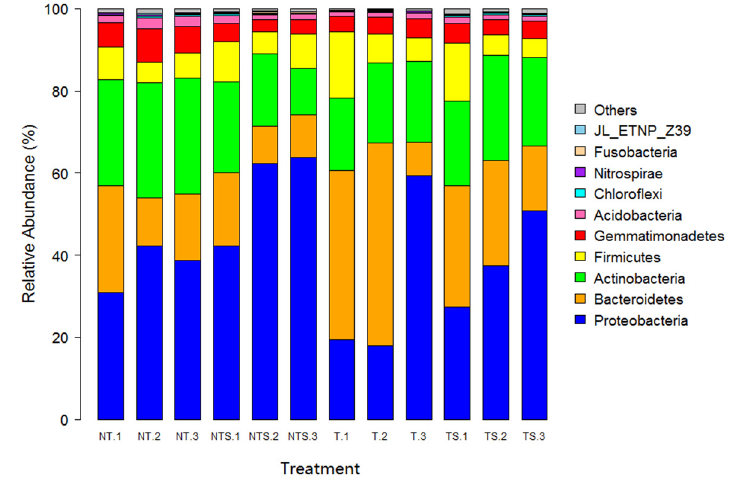
Figure 3. Relative abundance of top 10 soil bacterial phyla for all samples as affected by tillage and crop residue management treatments. NT, no-tillage with all crop residue removed at harvest; NTS, no-tillage with crop residue chopped and spread evenly on the soil surface; T, conventional tillage with all crop residue removed at harvest; TS, conventional tillage with all crop residue chopped, spread evenly on the soil surface, and incorporated into the soil via plowing. The numbers following the treatment name denote the sampling replications. For example, NT1, NT2, and NT3 means the soil sampling was taken from replicate 1, 2, and 3 of the field plots, respectively.